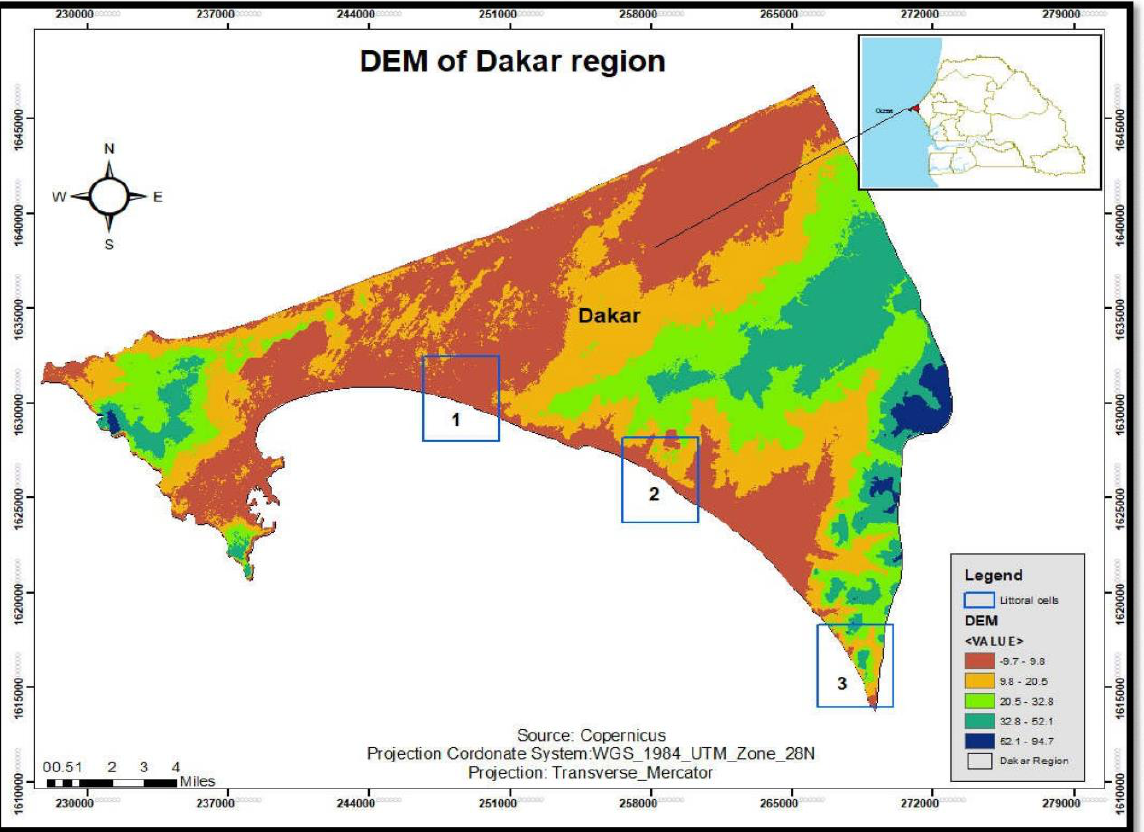
Figure 8. Determination of the slope values in the study area. Source: GLO-30 DEM.